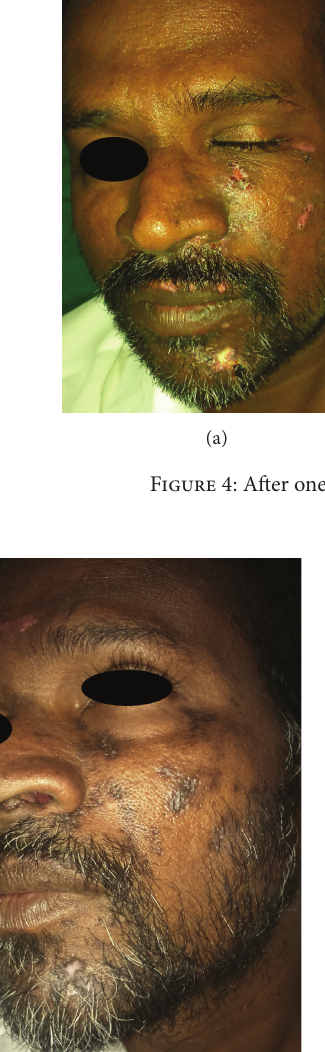
Figure 5: Healed ulcers extraorally after a month.